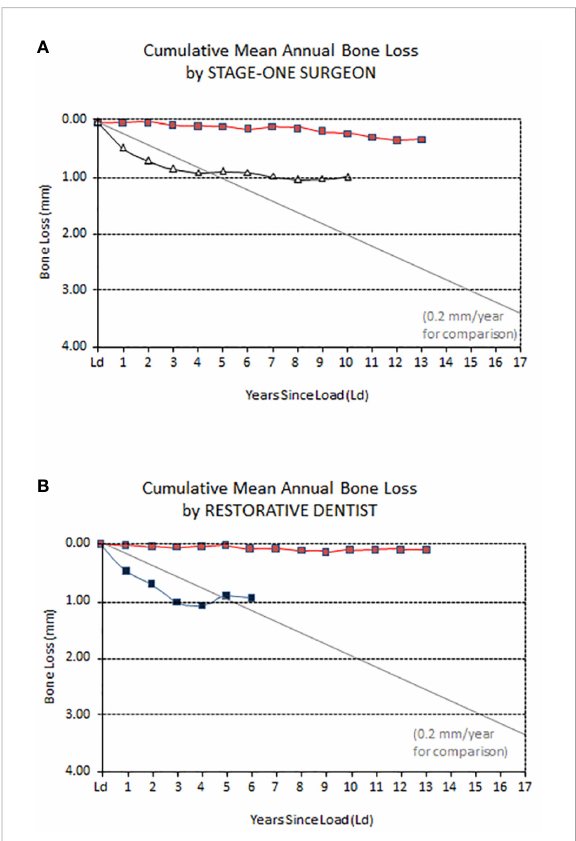
FIGURE 3 (A) This fi gure depicts the performance of one individual surgeon with respect to the cumulative, average, annual loss in marginal bone that was associated to this clinician (squares) whereas the triangles depict the average annual performance of another oral surgeon who saw much greater accumulated bone loss than his peer, despite them using the same implant type in similar patients. Both these surgeons were active at the University of Toronto, Canada. (B) The squares in this fi gure represent the cumulative, annual loss in marginal bone associated to two restorative dentists active at the University of Toronto, Canada some 20 years ago. The bone loss curves were constructed so that they started from zero levels by the investigator S Ross Bryant. Figures (A, B) indicate that if a given patient had the poor luck to be treated by the least good surgeon and followed up by the least good prosthodontist, this meant an average accumulated loss of marginal bone of 2 millimeters at about 3-4 years after implant treatment. These curves support the notion that marginal bone loss around oral implants need not always have a septic background. Created using data from S R